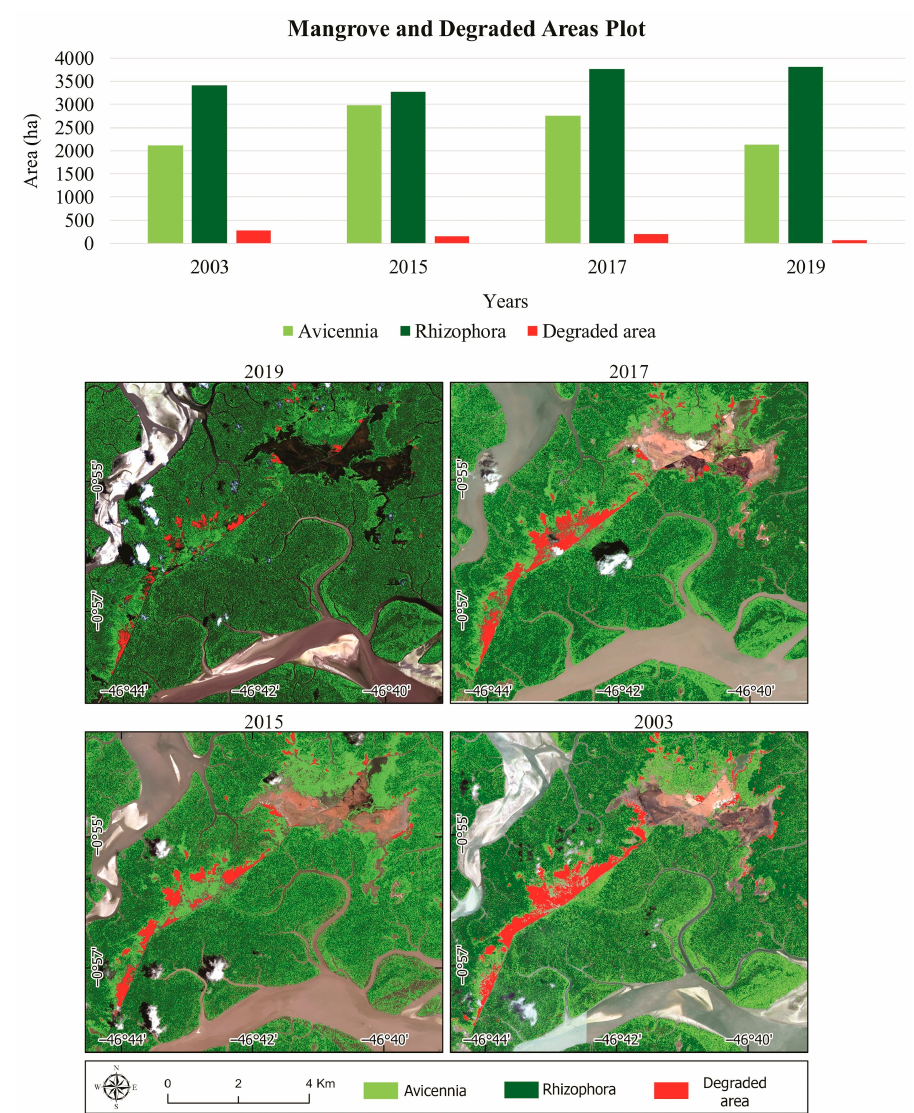
Figure 10. Graphs showing changes in areas dominated by Avicennia, Rhizophora, and degraded mangroves associated with the spatial-temporal changes of the mangrove cover in the Bragança Peninsula using high-resolution images from 2013 to